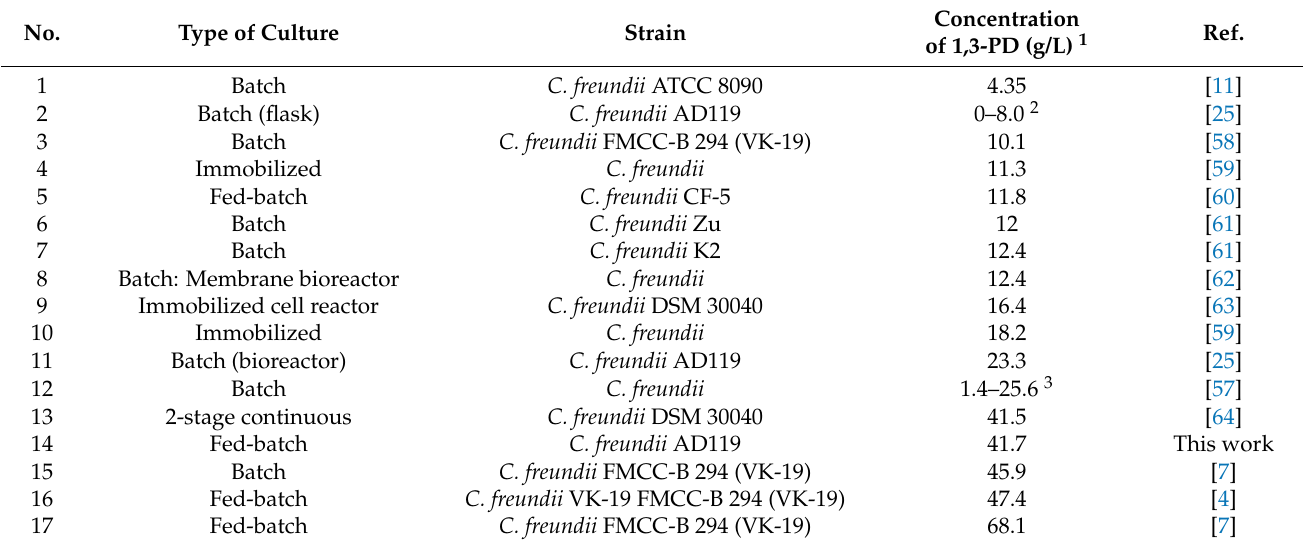
Table 7. 1,3-PD production by C. freundii dependent on types of culture and strain.